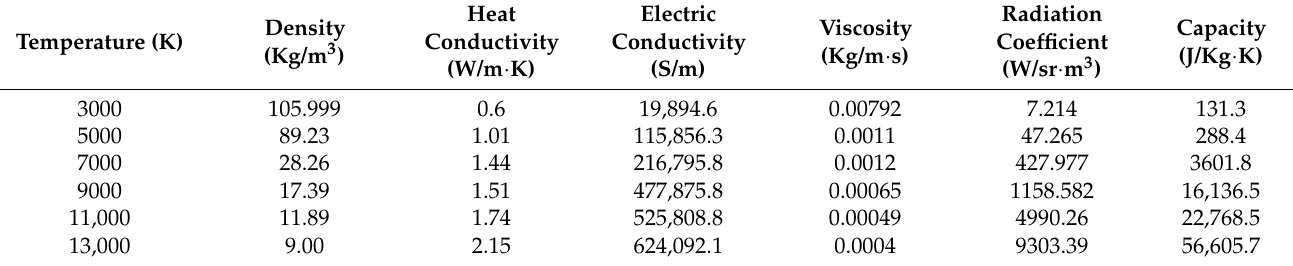
Table 4. Arc physical